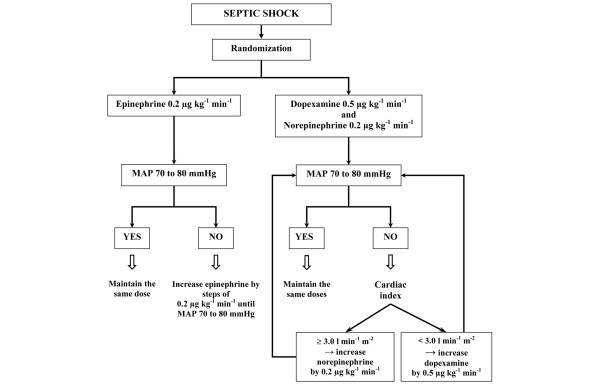
Algorithm of doses adaptation in the two groups. MAP, mean arterial pressure.